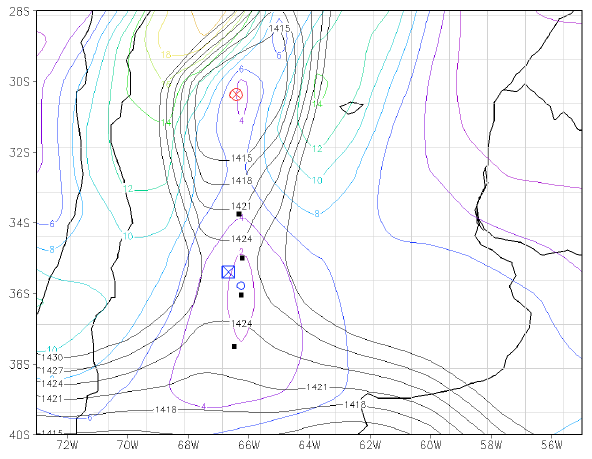
Fig. 2. Contours show the magnitude of ∇ φ 850 (colors) and φ 850 (black). Markers indicate: position of NAL (red circle), AC as can- didate positions (black), position of AC as detected by the gradient (blue circle) and position of AC corrected using φ 850 (blue square).